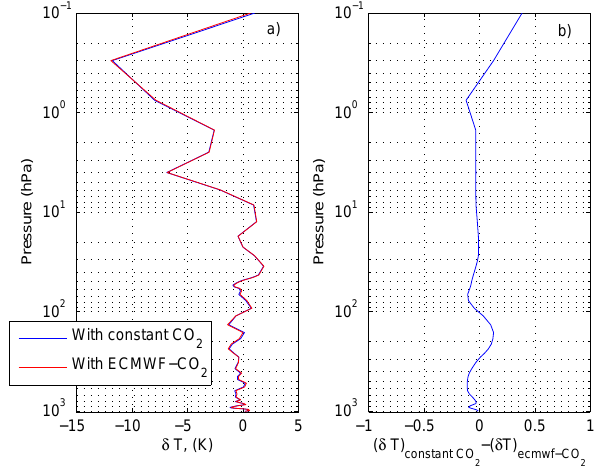
Fig. 15. Panel (a) shows the average difference (IASI retrieval- ECMWF) for temperature for the two inversion case studies: (1) constant mixing ratio for CO 2 and (2) with the ECMWF-altitude- dependent CO 2 mixing ratio, respectively. Panel (b) gives the dif- ference between the two curves shown in (a) .